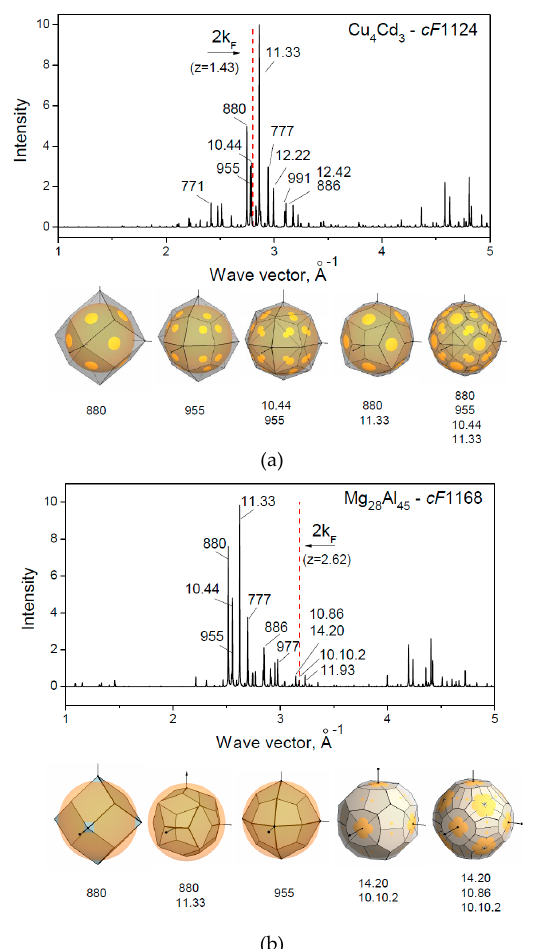
Figure 1. Calculated diffraction patterns for complex intermetallic phases (upper panel) and corresponding Brillouin-Jones zones with the Fermi spheres (lower panel). The position of 2k F for a given valence electron number per atom z and the hkl indices of the planes used for the BZ construction are indicated on the diffraction patterns. ( a ) Cu 4 Cd 3 - cF 1124; and ( b ) Mg 28 Al 45 - cF 1168. Structural data and FS–BZ evaluation data are given in Table 1.